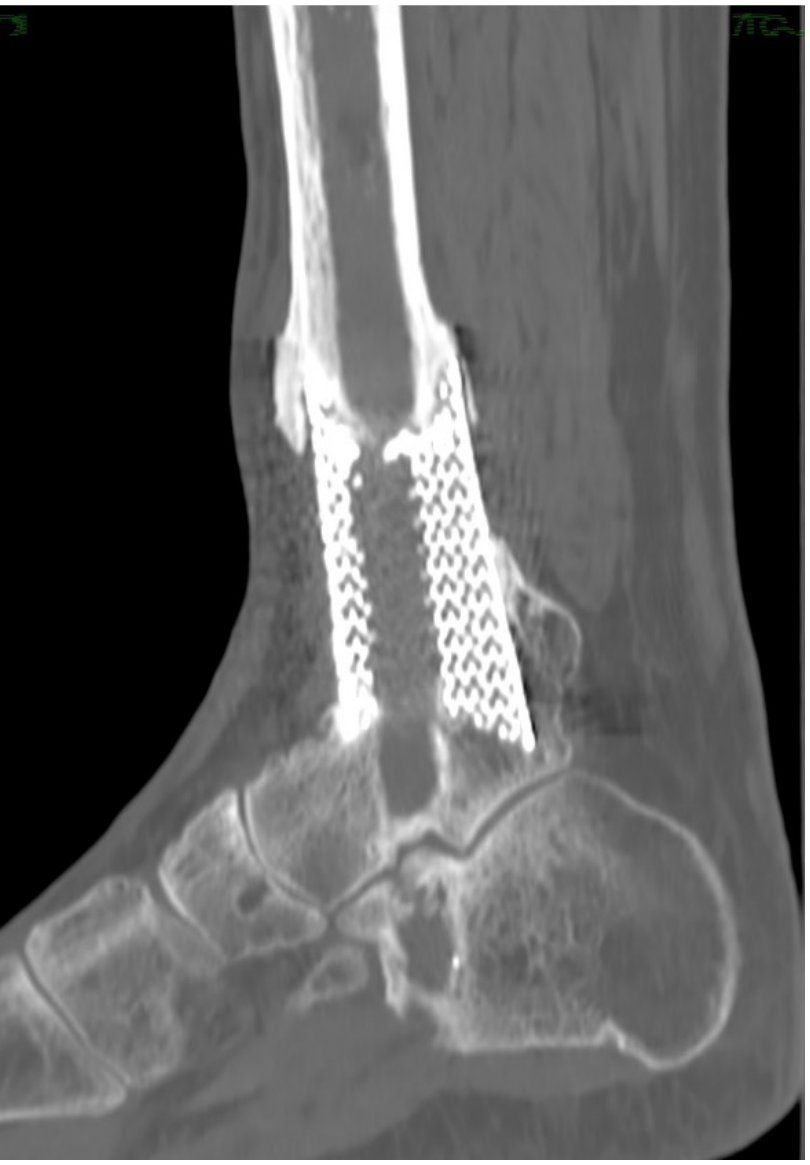
Figure 5. CT scan at final follow-up, after intramedullary nail removal. Note the proximal and distal osteointegration of the custom-made implant.